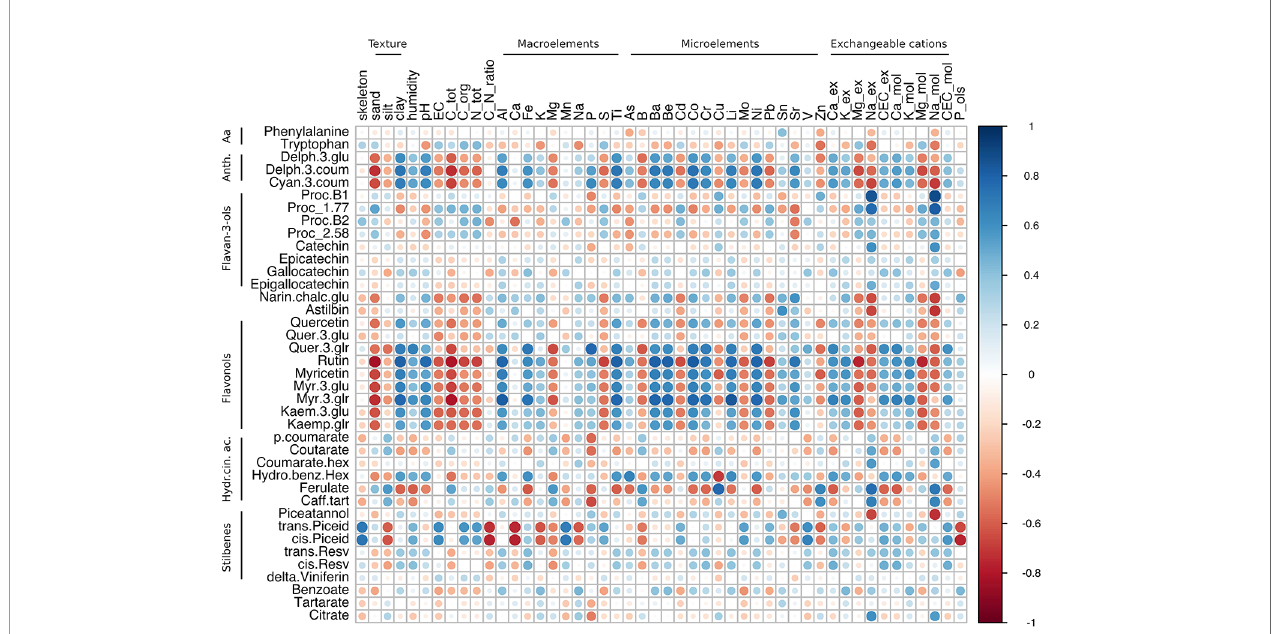
FIGURE 5 | Correlation analysis of grape skin secondary metabolites of cv. Glera at harvest against the physico-chemical characteristics of the soil. The analysis was generated using Pearson's